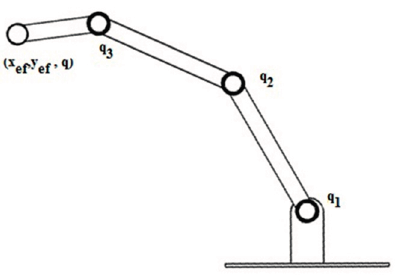
Figure 1. Scheme of 3-DOF serial robotic